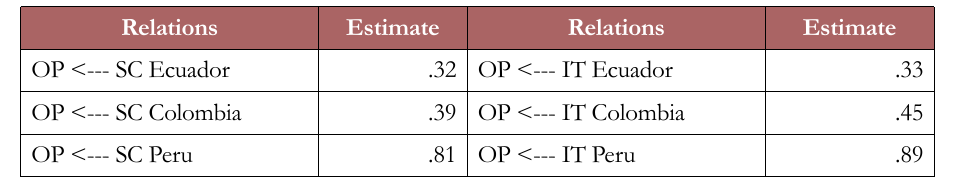
Table 6. Standardized